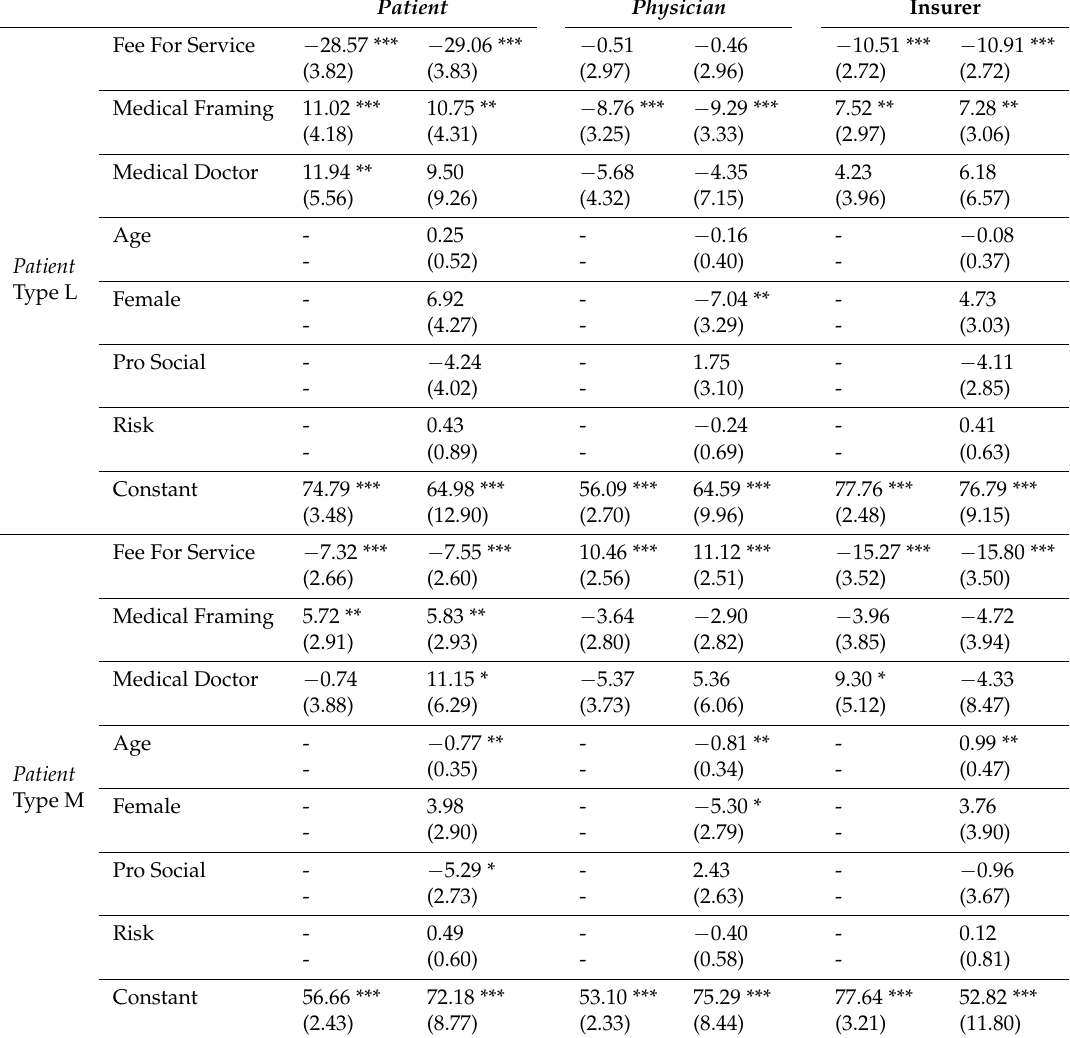
Table A15. Regression results—payoff for different participants by Patient